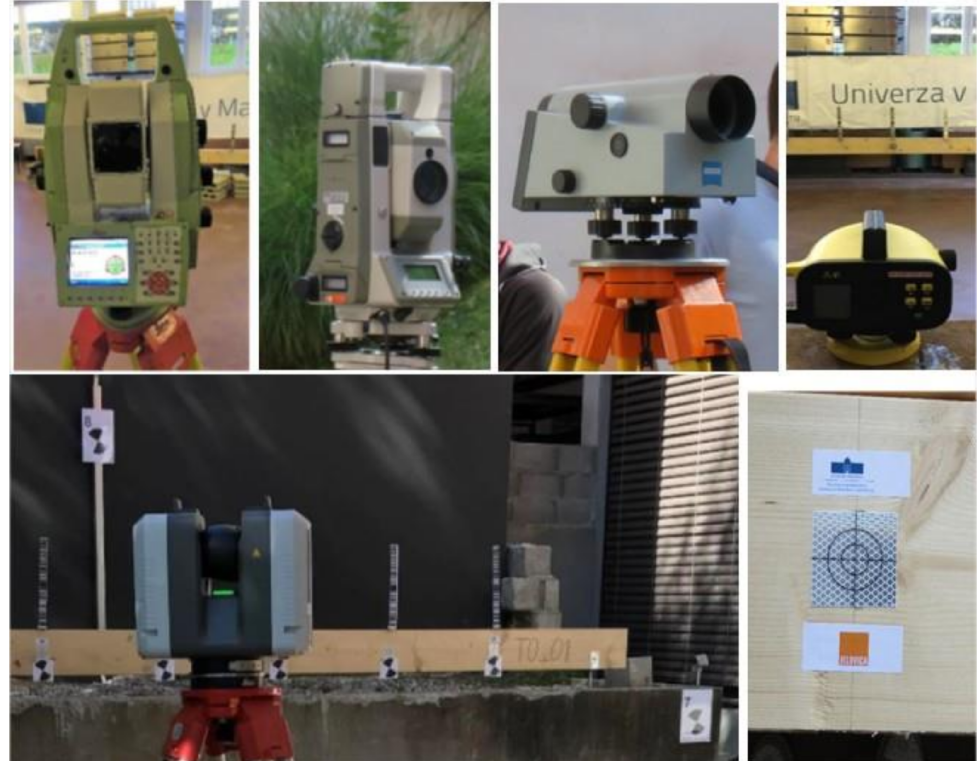
Figure 4. Measuring equipment used and marked measuring points (Leica TS 50, Nikon DTM700,